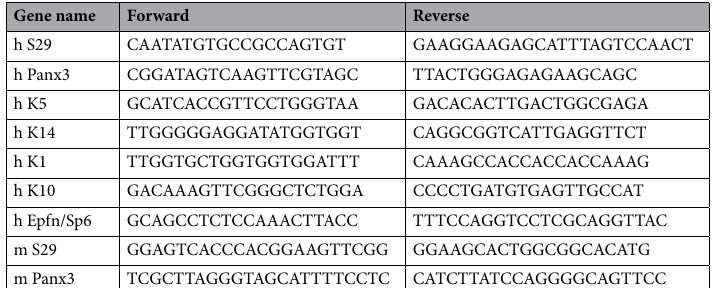
Table 1. List of primers for RT-PCR. h: human, m: